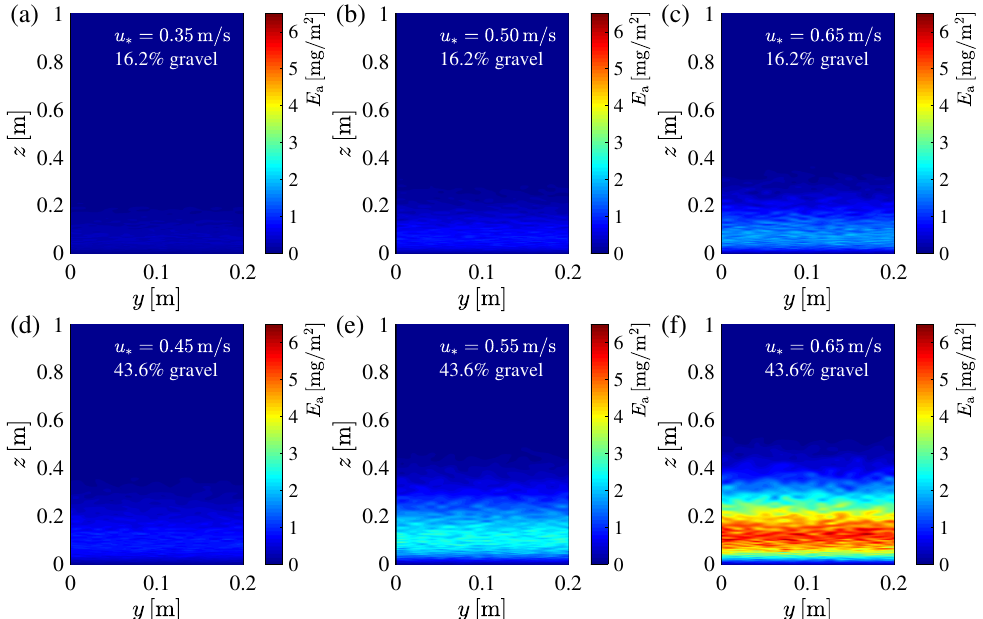
Figure 6. Spatial distribution images of impact erosion amount E a [ mg/m 2 ] in sand drift at t = 5.0s, for ( a – c ) on Gobi with 16.2% gravel coverage and ( d – f ) on Gobi with 43.6% gravel